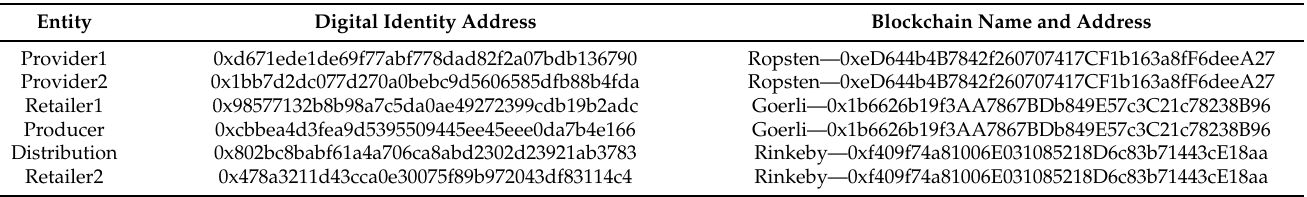
Table A1. Entities digital identity and blockchain supply-chain system